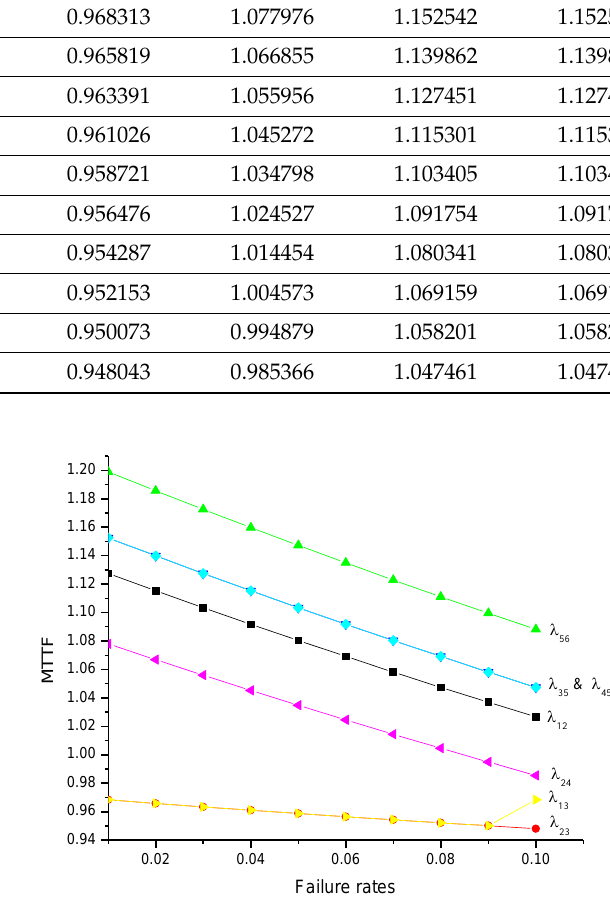
Table 3. MTTF of the Communication Network.